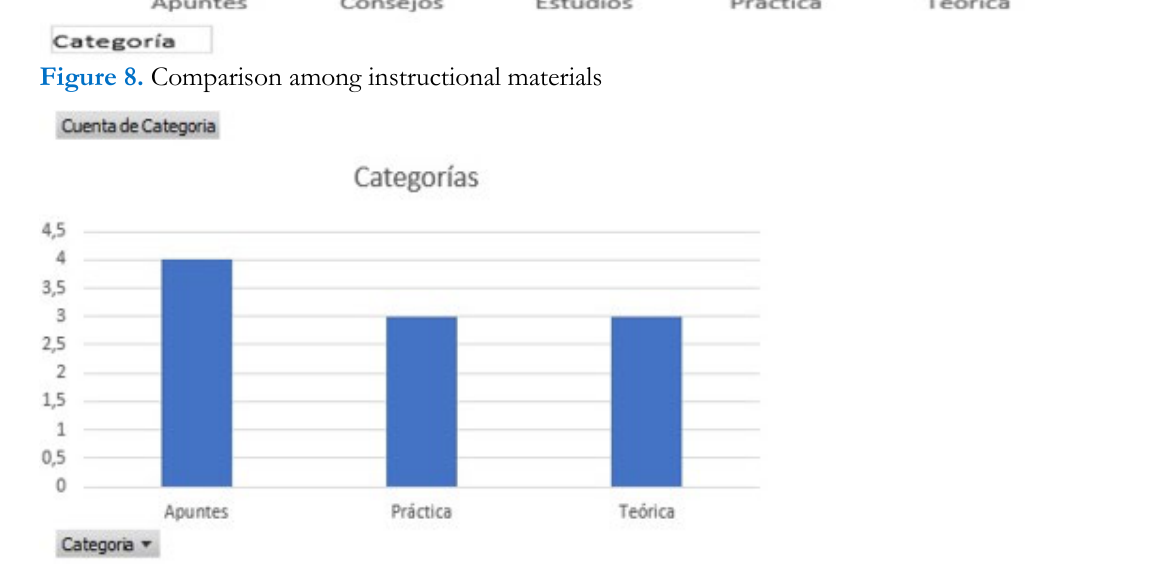
Figure 9. Comparison among instructional